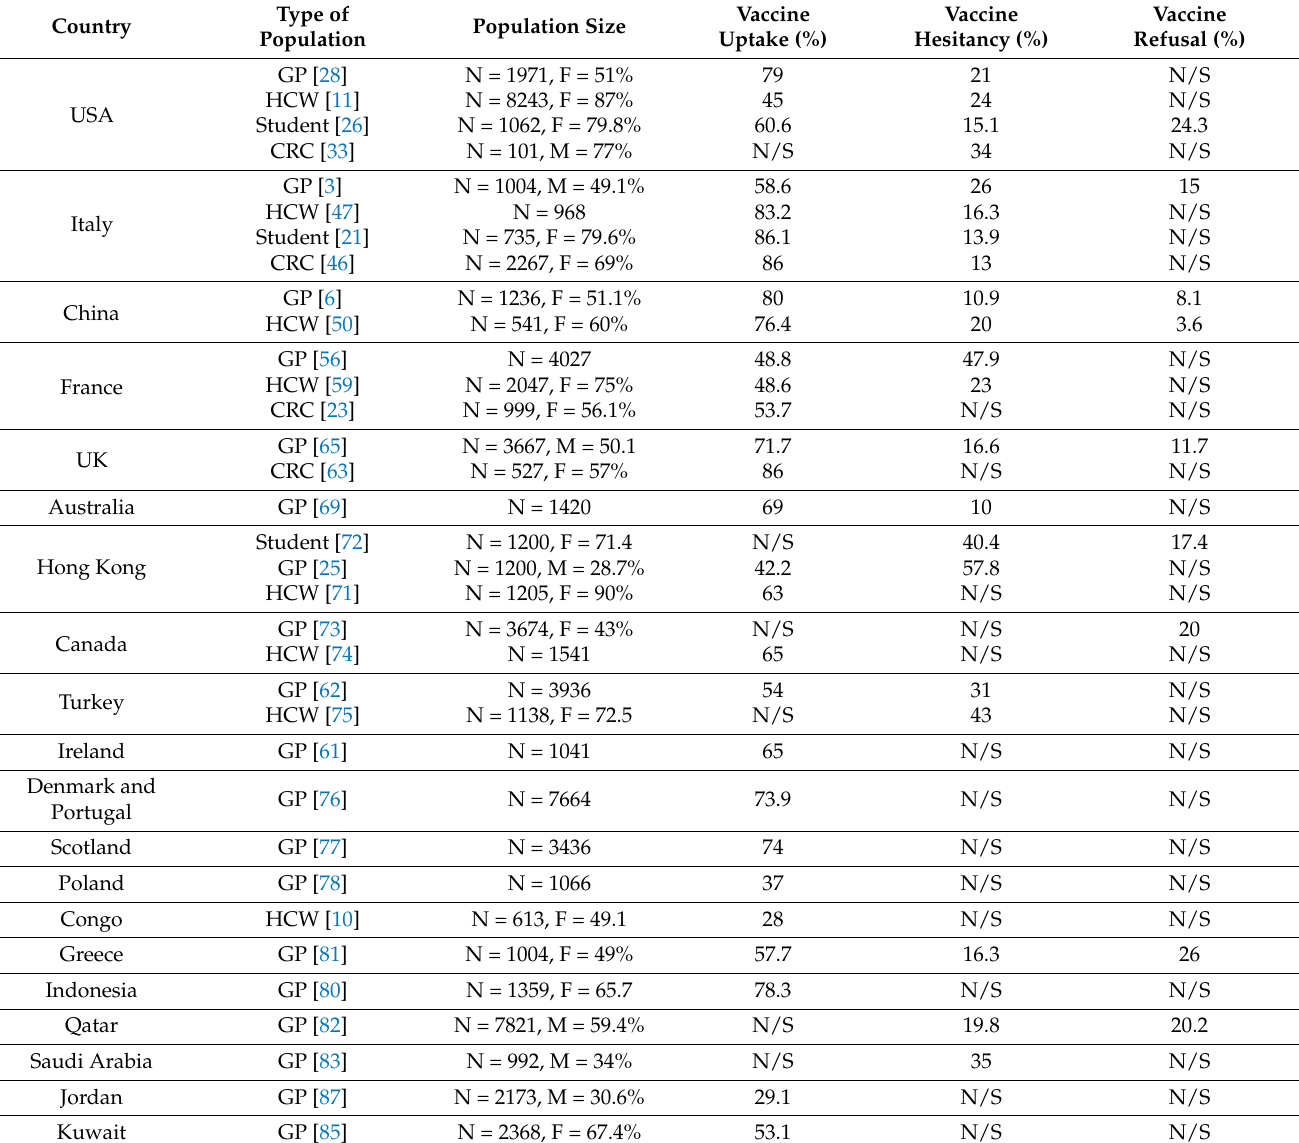
Table 3. COVID-19 vaccine coverage